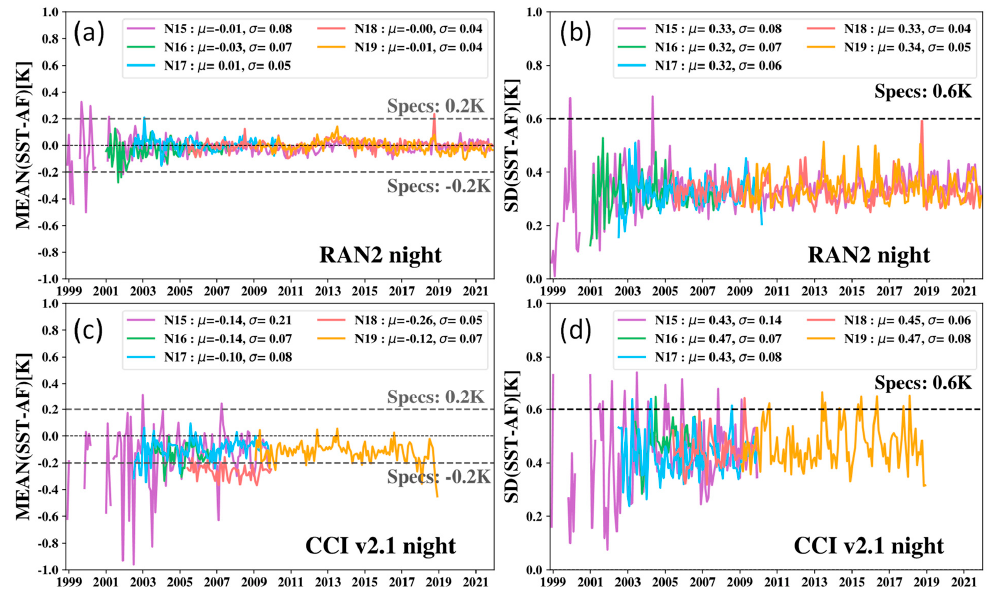
Figure 19. Time series of global monthly ( a , c ) biases and ( b , d ) SDs of ( a , b ) RAN2 ‘depth’ and ( c , d ) CCI ‘depth’ SST with respect to AF. (Data are from the NOAA SQUAM system [21,22].)